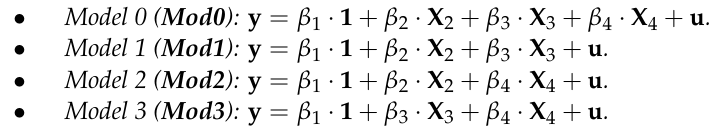
Table 3. Variance inflation factor (VIF) and VIF uncentered (VIFnc) of models proposed from Belsley [1] dataset.